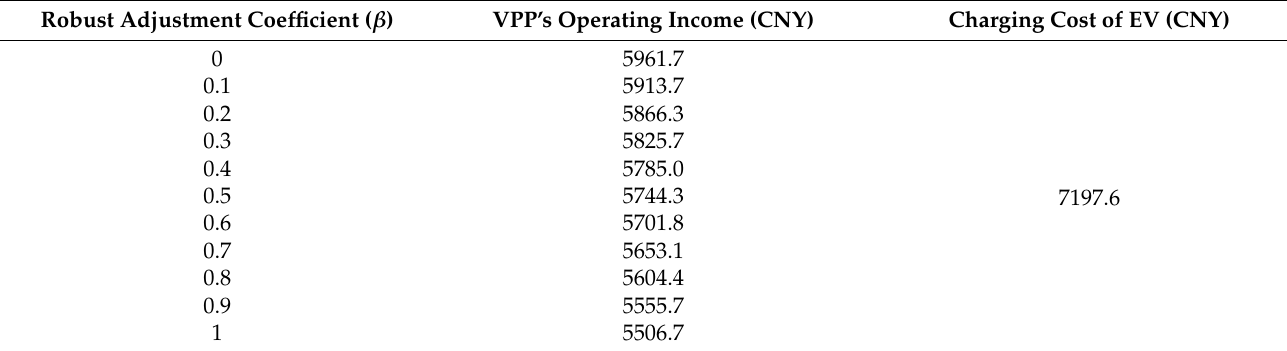
Table 6. Predicted value of wind turbine